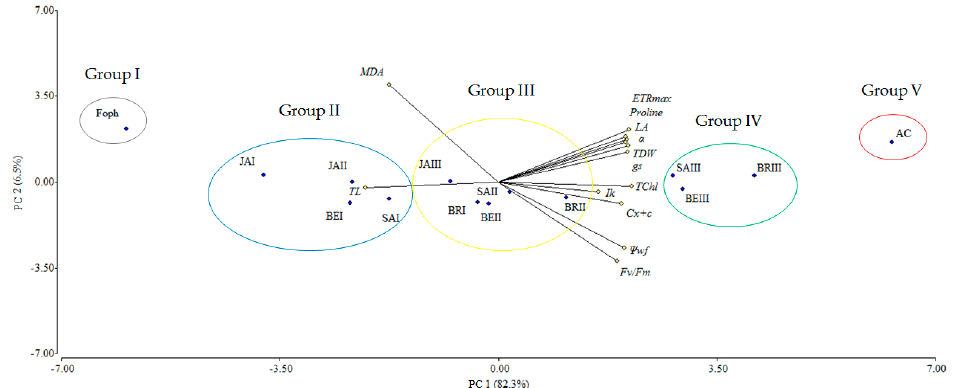
Figure 10. Effect of the different number of sprays (0, 1, 2 and 3 applications) of synthetic elicitors (Salicylic acid (SA), jasmonic acid (JA), Brassinosteroids (BR), or botanical extracts (BE)) on the biplot analysis of cape gooseberry plants inoculated with Fusarium oxysporum f. sp. physali at 50 days after inoculation (DAI). Abbreviations: AC, absolute control (Non-inoculated plants and without any synthetic elicitor spray); Foph, plants inoculated with only Foph without any synthetic elicitor spray; BRI, Foph-inoculated plants with one foliar BR application; BRII, Foph-inoculated plants with two foliar BR applications; BRIII, Foph-inoculated plants with three foliar BR applications; SAI, Foph-inoculated plants with one foliar SA application; SAII, Foph-inoculated plants with two foliar SA applications; SAIII, Foph-inoculated plants with three foliar SA applications; JAI, Foph-inoculated plants with one foliar JA application; JAII, Foph-inoculated plants with two foliar JA applications; JAIII, Foph-inoculated plants with three foliar JA applications; BEI, Foph-inoculated plants with one foliar BE application; BEII, Foph-inoculated plants with two foliar BE applications; BEIII, Foph-inoculated plants with three foliar BE applications; PC, principal component.